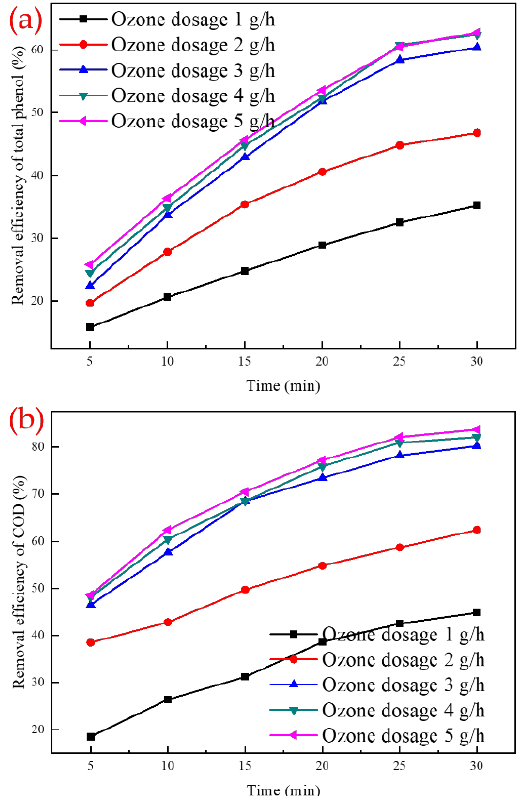
Figure 7. Effects of ozone dosages on removal efficiency of ( a ) total phenol and ( b ) COD.